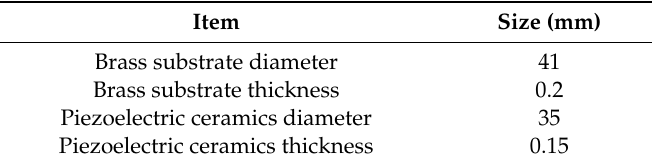
Table 2. The size parameters of the PZT vibrator.